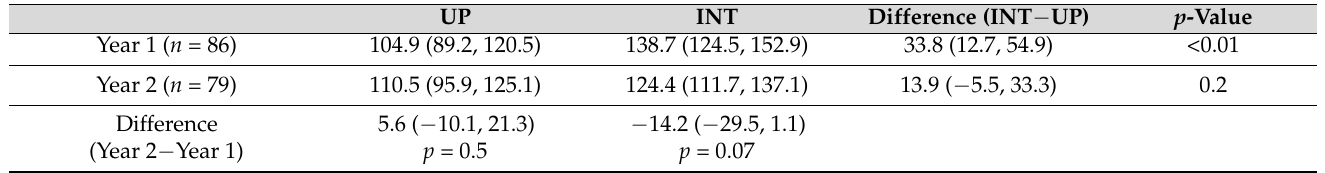
Table 4. Physical activity delivery (min/week) by teachers at usual practice (UP) and intervention (INT) schools during year 1 and year 2 as determined using weekly activity logs. Values are mean (95%